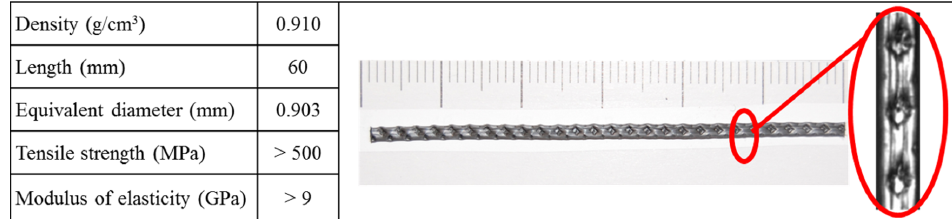
Figure 1. Commercial polyolefin fiber. Scale in mm. Mechanical properties supplied by the manufacturer (Sikafiber M60, Madrid, Spain).